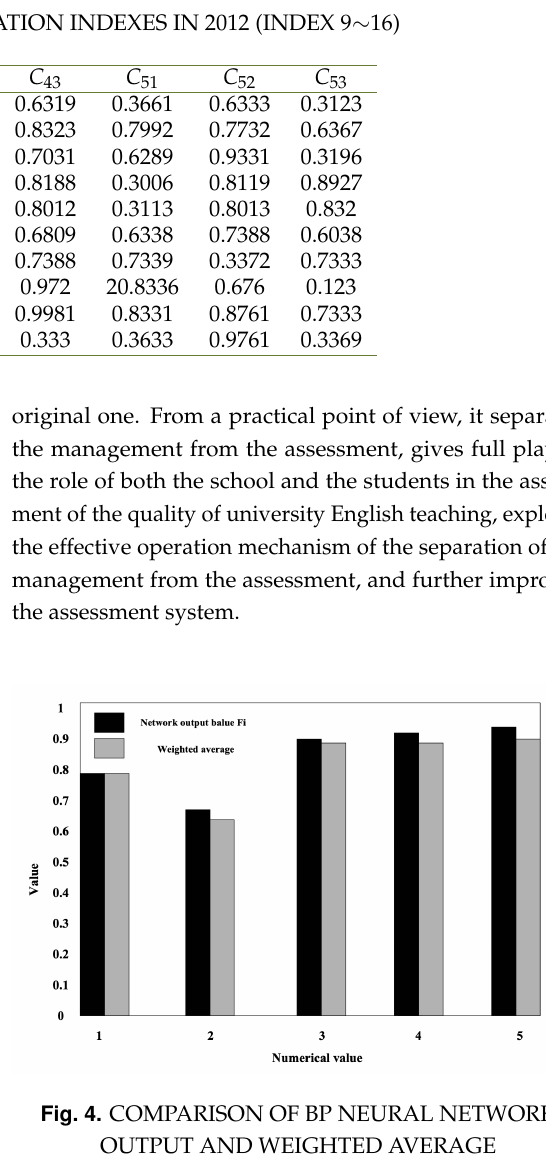
Table 5. THE NORMALIZATION DATA OF THE 20 PRIMARY AND SECONDARY SCHOOL EDUCATION